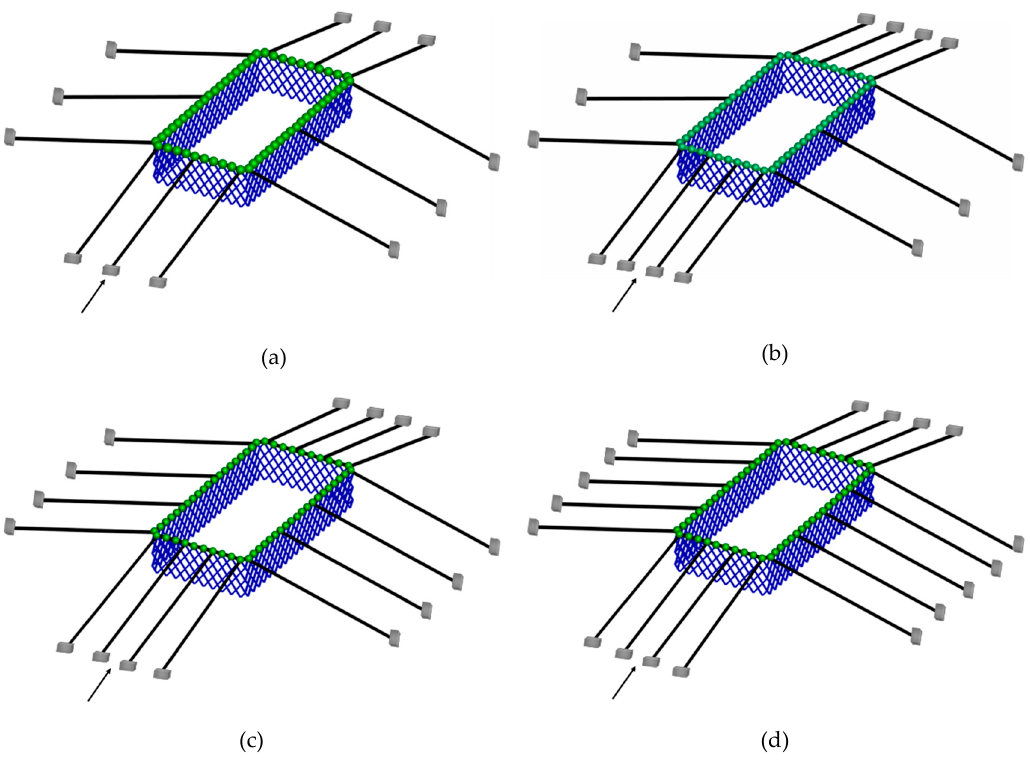
Figure 14. Diagram of floating rope enclosure with different amount of mooring system. ( a ) Figure14. Diagramoffloatingropeenclosurewithdi ff erentamountofmooringsystem. ( a ) Configuration Configuration A; ( b ) Configuration B; ( c ) Configuration C; ( d ) Configuration D. A; ( b ) Configuration B; ( c ) Configuration C; ( d ) Configuration